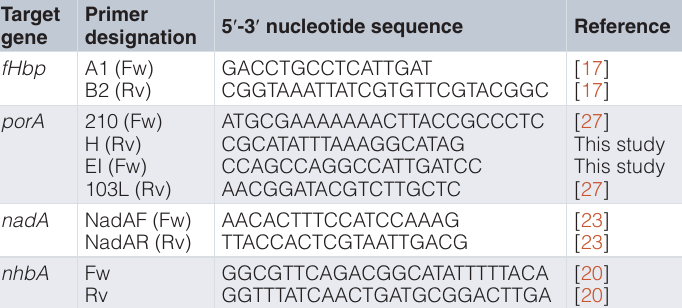
Table 2. Primers used for PCR amplification and sequencing of the genes fHbp , porA , nadA snd nhbA